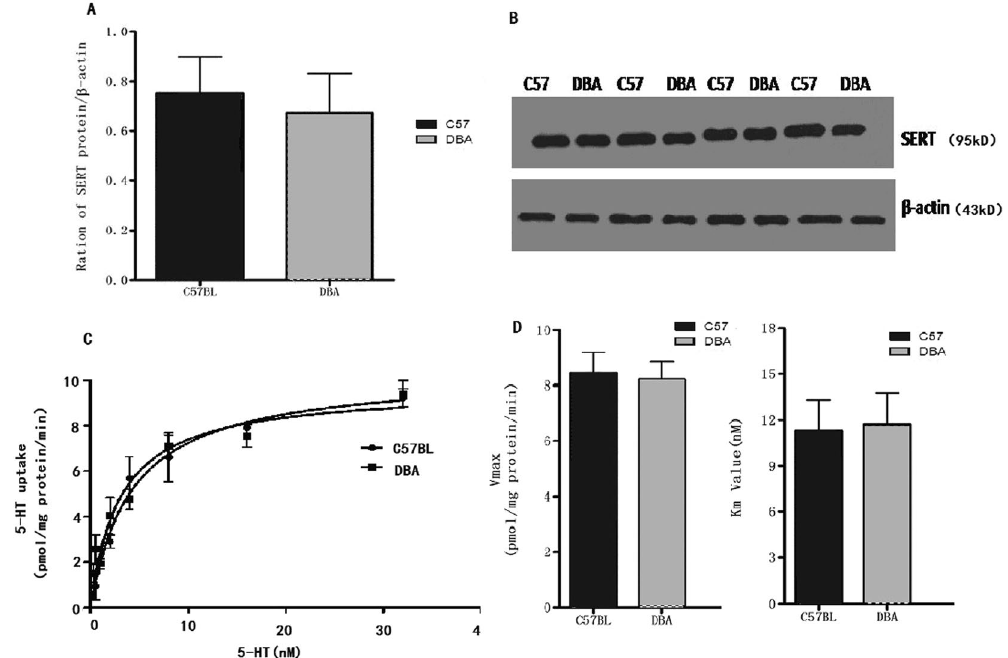
Figure 4. SERT protein expression ( A ) was measured by Western blotting (right) and normalized to β -actin levels ( B ); the samples were derived from the same experiment, and the gels were processed in parallel. SERT expression did not differ between C57BL/6J and DBA/2J mice (Student’s t-test, p > 0.05; n = 4 per strain). Saturation uptake kinetics in C57BL/6J and DBA/2J mice whole-brain synaptosomes ( C , D ). C57BL/6J and DBA/2J mice do not differ in 5-HT transport activity (C57BL/6J:V m 8.23 ± 2.28 nM; K max 6.54 ± 1.27 pmol/ min-mg protein; DBA/2J: K m 7.51 ± 2.67 nM; V max 12.22 ± 3.09 pmol/min-mg protein: Student’s t-test, p > 0.05, n = 6 per